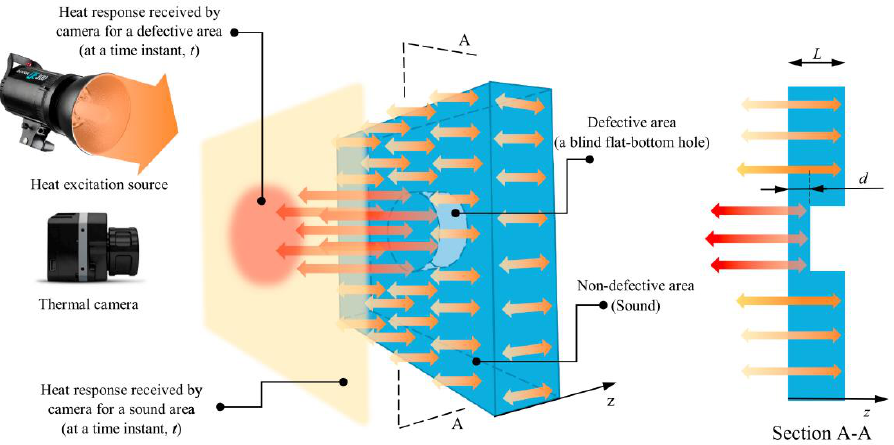
Figure 9. The principles of thermography (Reprinted with permission from ref. [52]. Copyright 2019 Elsevier).